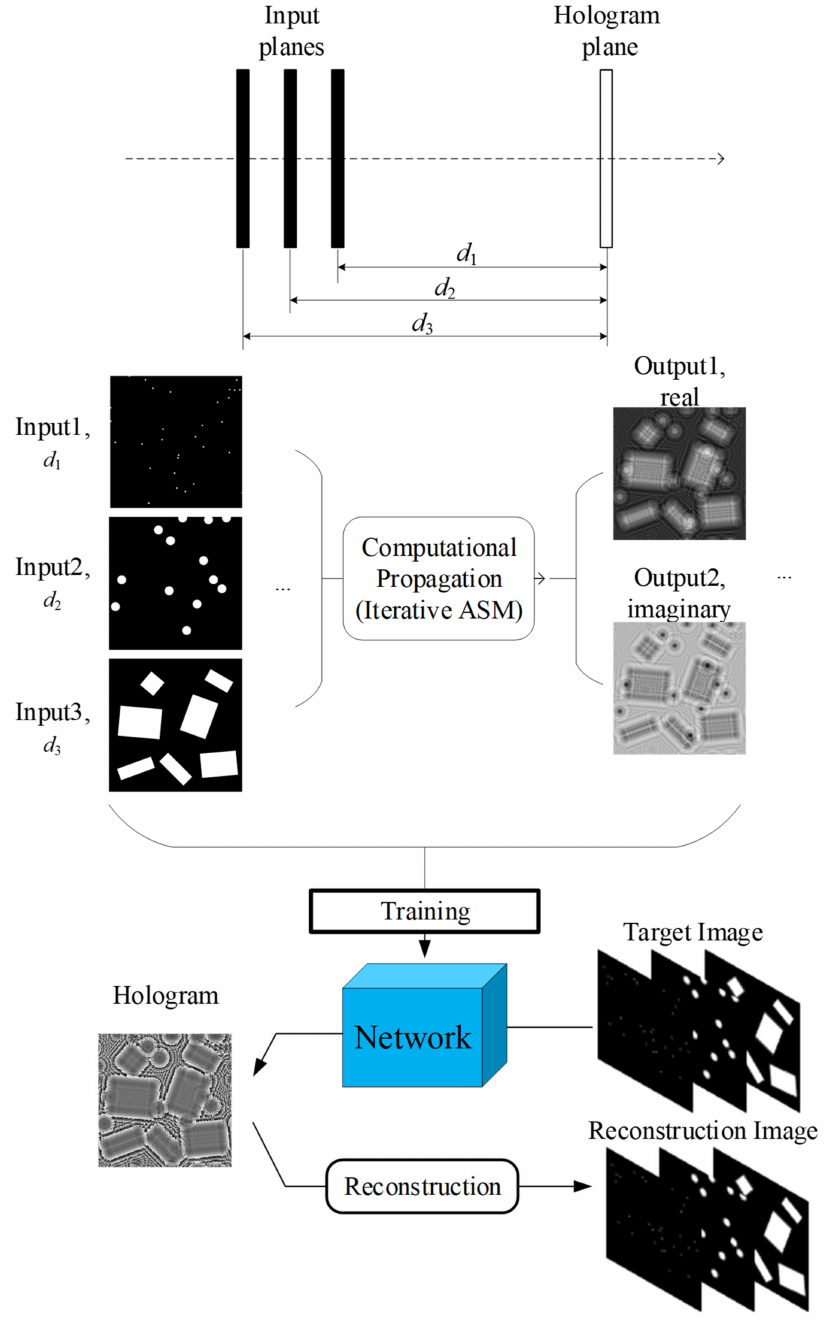
Figure 2. Diagram of neural network for hologram